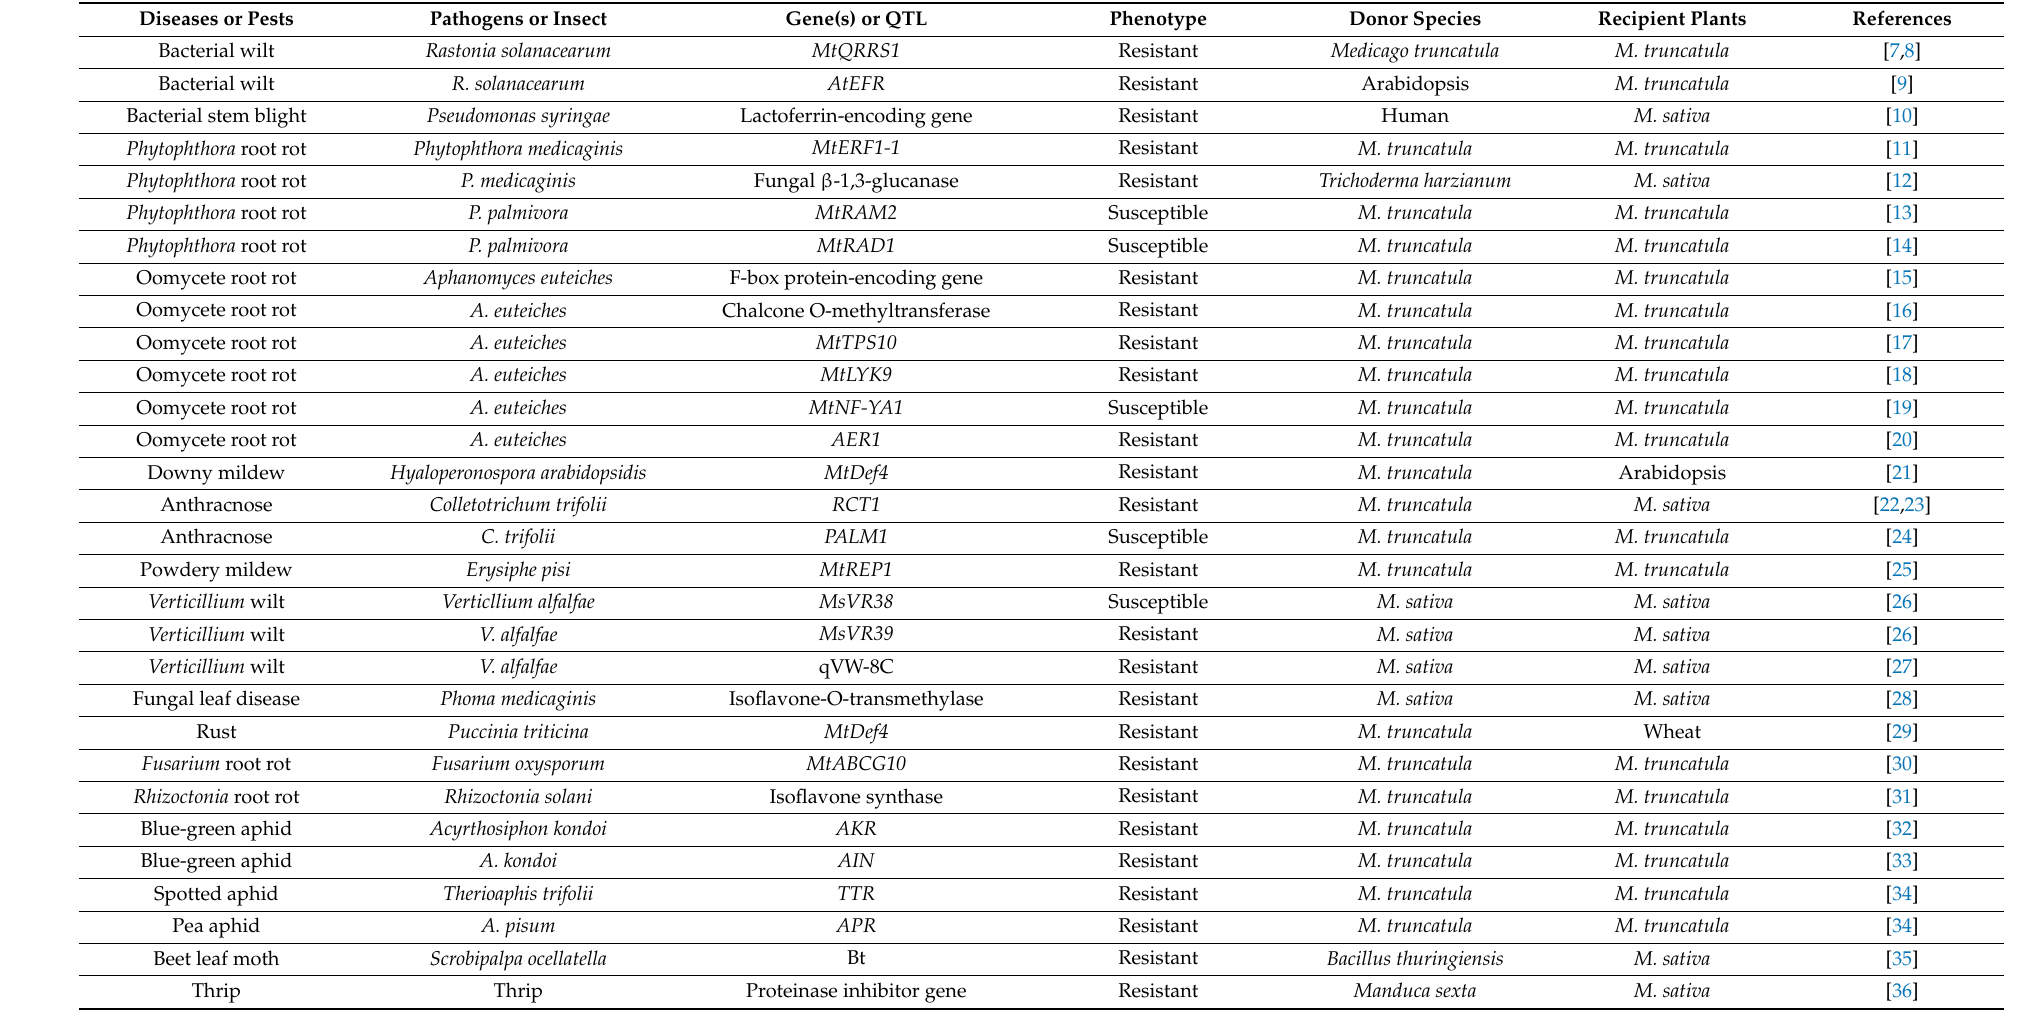
Table 1. Disease or insect resistance genes or QTL identified in alfalfa or Medicago truncatula